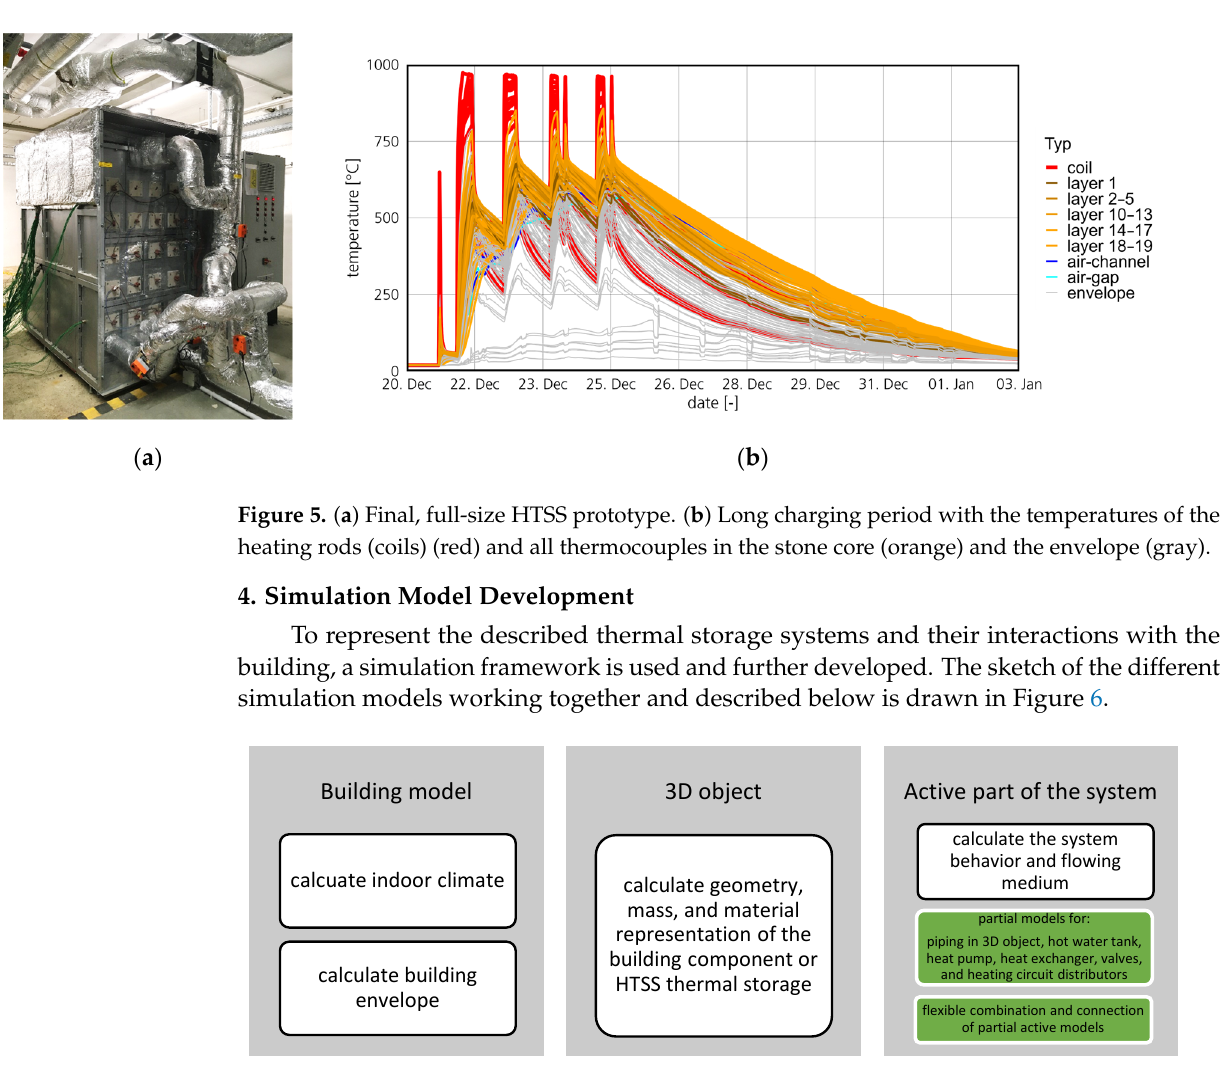
Figure 6. Sketch of different simulation models working together to build the whole building simulation framework to design and investigate the presented thermal storage